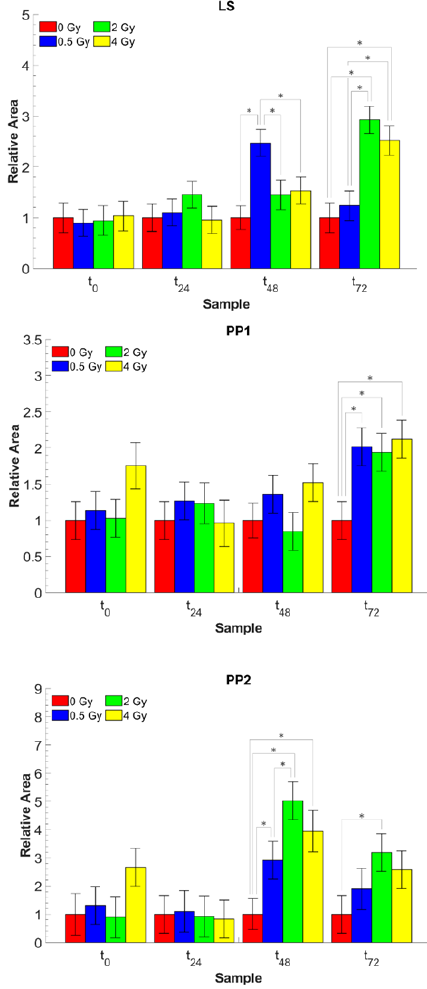
Figure 6. Comparison of the LS, PP1, and PP2 absorbance area ratios for MCF-10A human breast epithelial cells for different proton doses and different fixation times. See Table 1 for details on the reported ratios (Mean ± SD), which are normalized to the corresponding ratio value of the non-irradiated sample. Asterisks indicate significant differences ( p < 0.05).